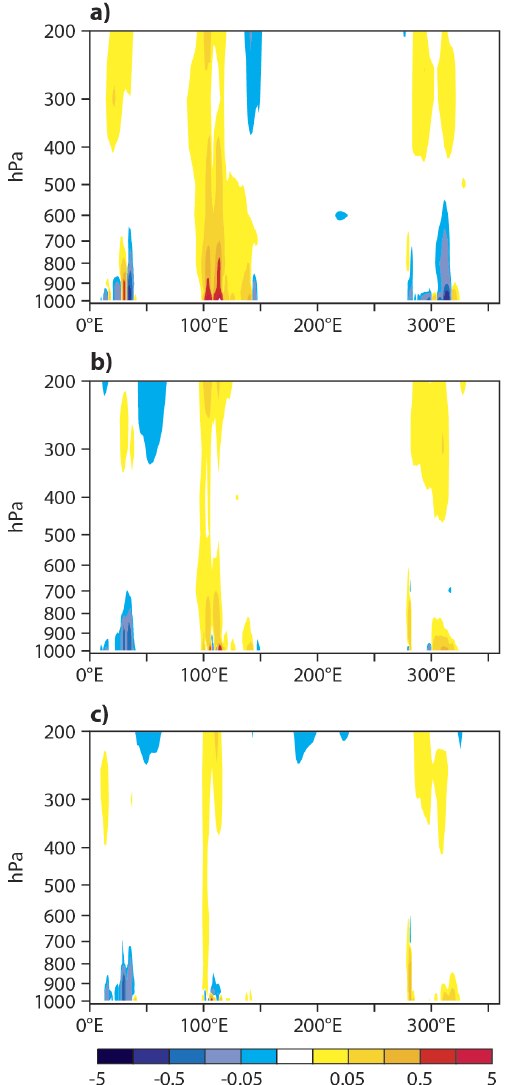
Figure 12. The same as Fig. 9 but for smoke aerosol in